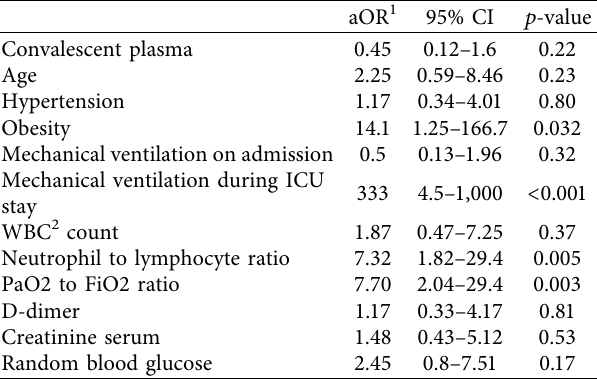
Table 3: Multivariate analysis on factors confounding mortality.